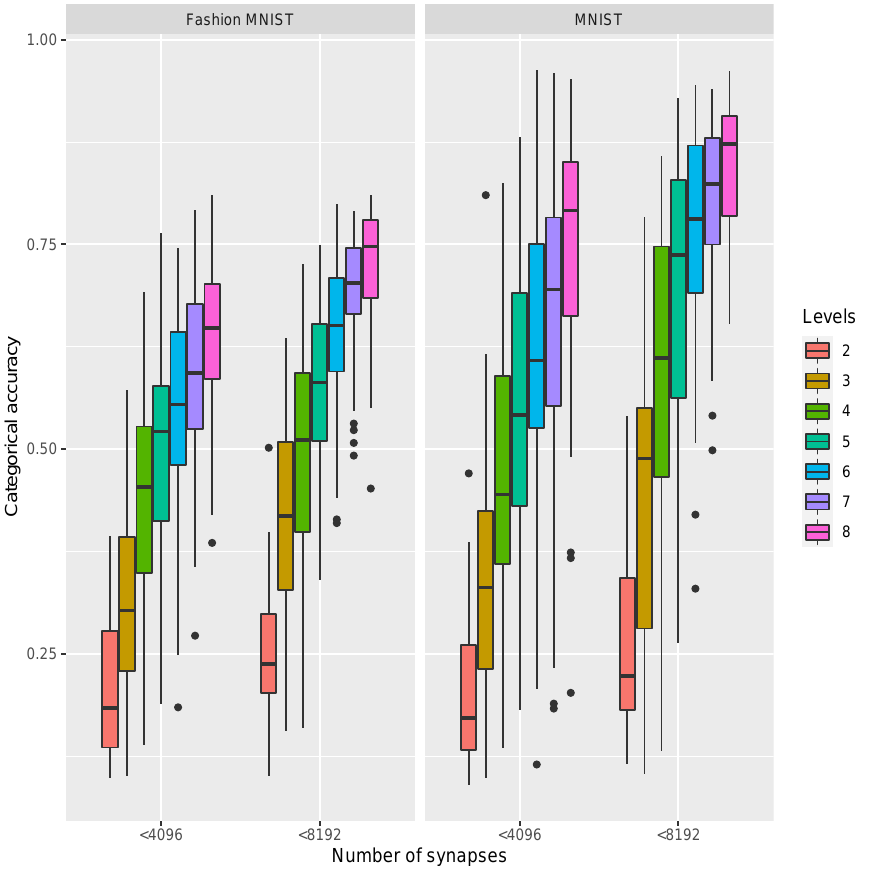
Figure 9. Boxplots for the categorical accuracy obtained for the MNIST and Fashion MNIST datasets in the test subset for both FdNN and CNN with different number of synapses categorized in two groups: less than 4096 and between 4096 and 8192 synapses for each experiment using quantization levels between 2 and